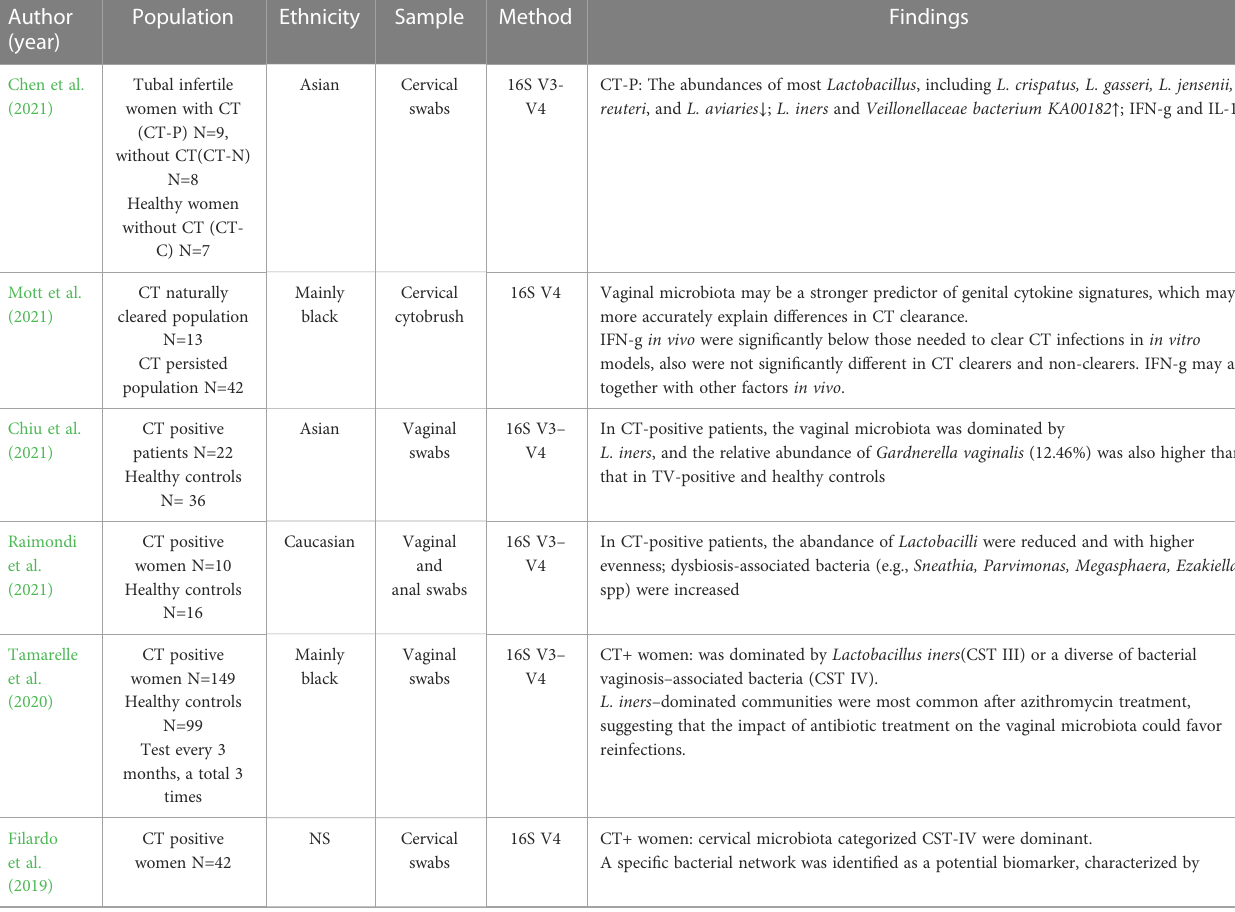
TABLE 3 The clinical studies of cervicovaginal microbiota sequencing in CT infection